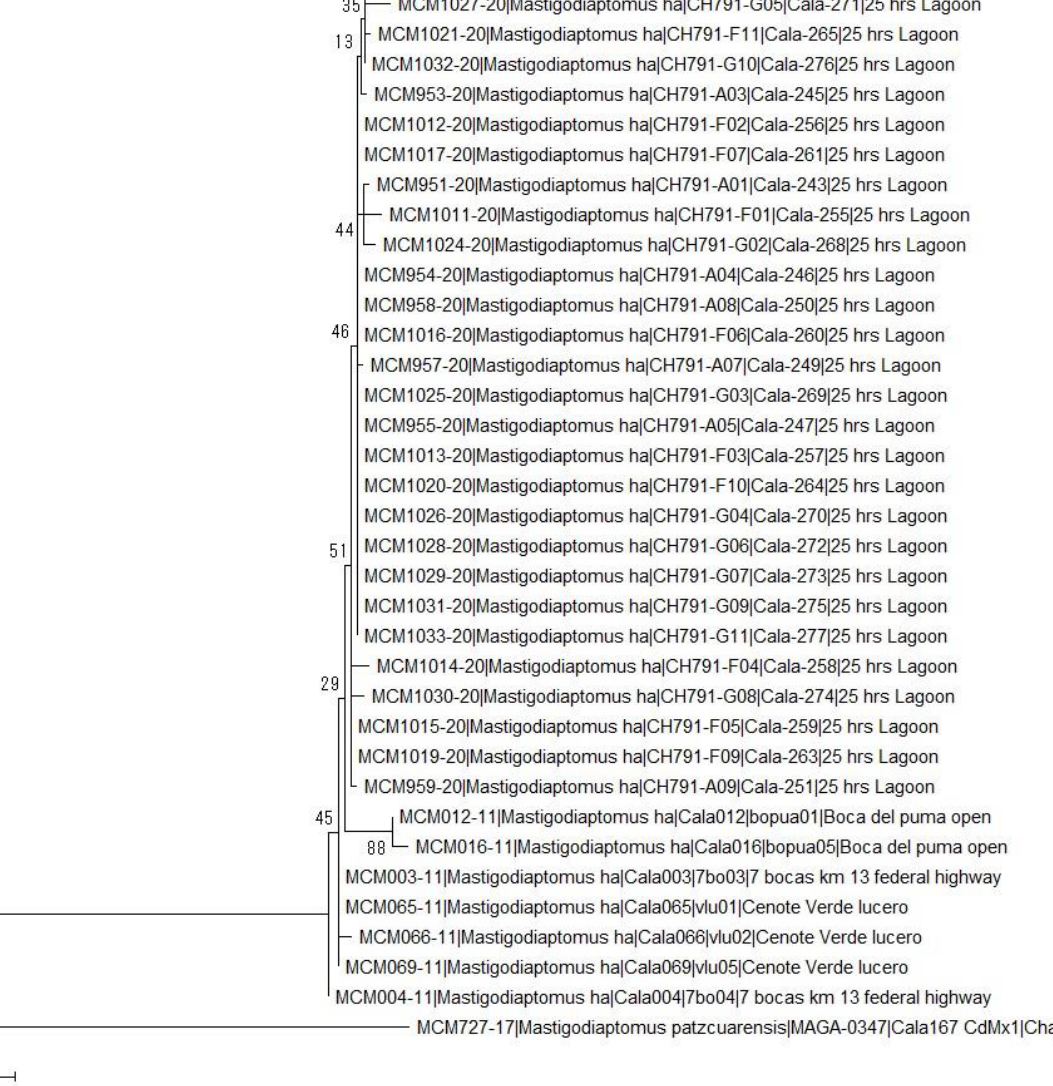
Figure 2. Analysis for Mastigodiaptomus ha (Quintana Roo, Mexico) with the maximum likelihood method to observe genetic relationships between continental and insular populations (1000 replicates), based on the COI gene. The scale length represents the percentage of genetic distance between